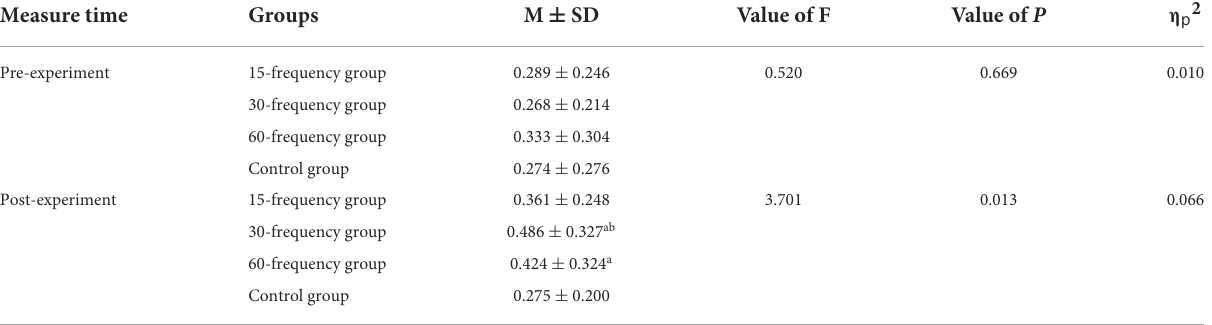
TABLE 4 Simple effect analysis and paired-sample t -test on subjects’ kinetic acuity. Measure time